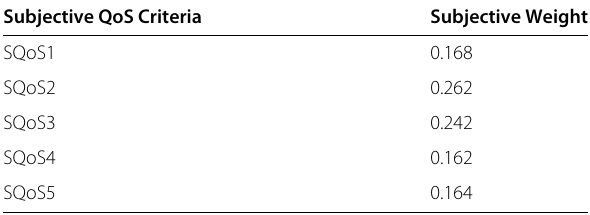
Table 7 Subjective Weight of QoS Criteria